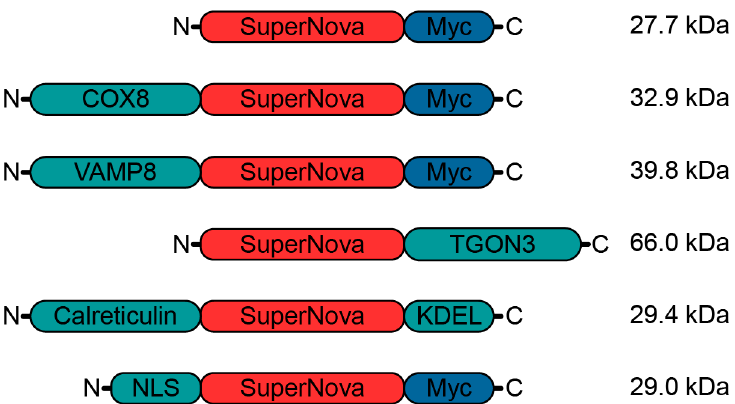
Figure 1. Schematic overview of SuperNova fusion proteins. Myc: myc-tag; COX8: mitochondrial protein cytochrome c oxidase subunit 8A; VAMP8: endosomal vesicle associated membrane protein 8; TGON3: trans-Golgi network integral membrane protein 2; Calreticulin: endoplasmic reticulum (ER) protein; KDEL: ER-retention signal; NLS: nuclear localization signal. Molecular weights of the fusion constructs are indicated.